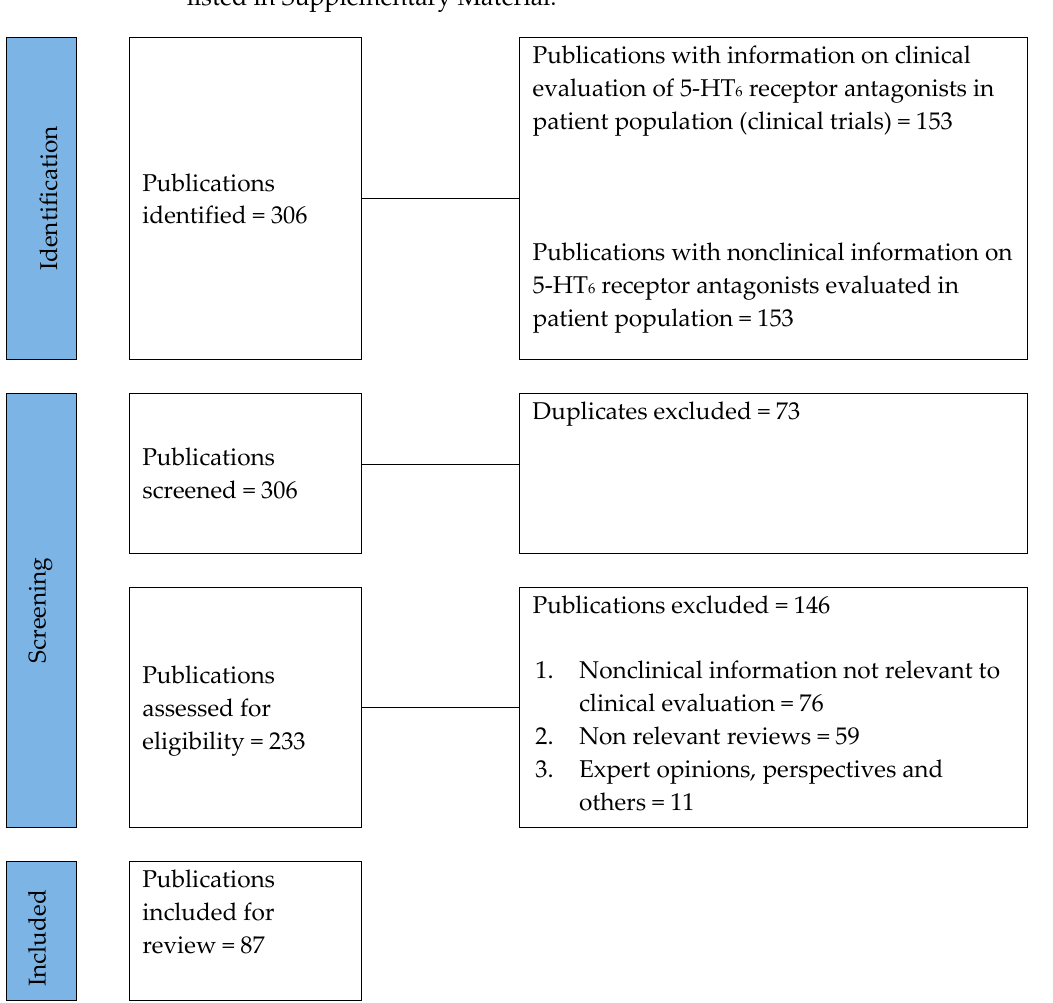
Figure 1. PRISMA flow diagram.